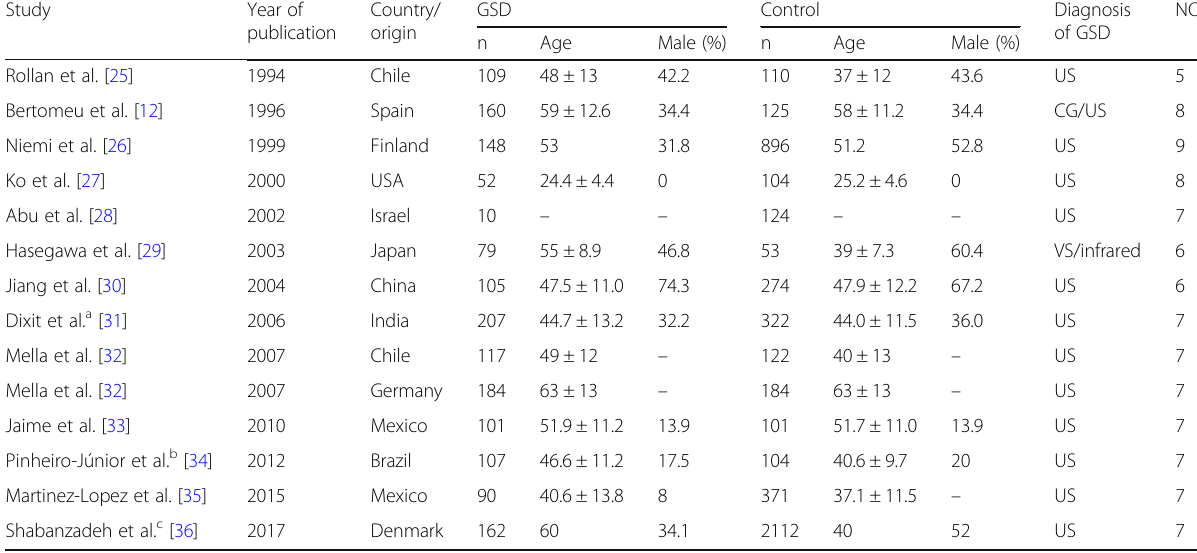
Table 1 Basic characteristics of all the studies included in the meta-analyses